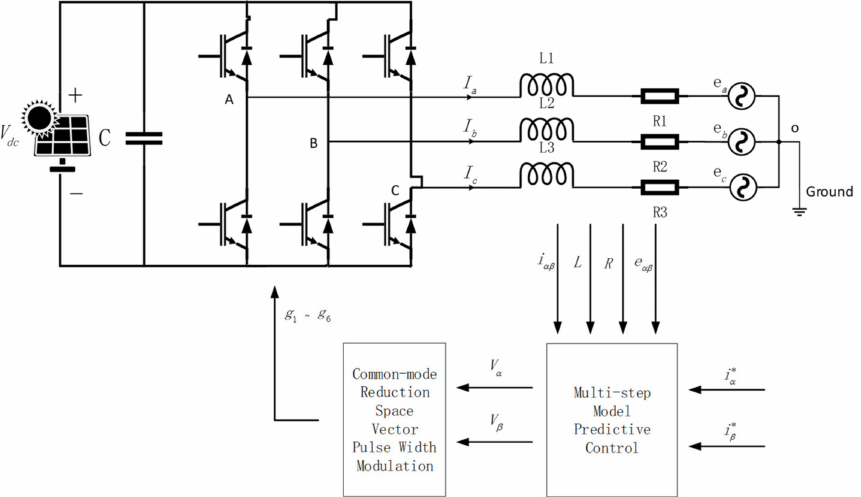
Figure 8. Overall structure of simulation.